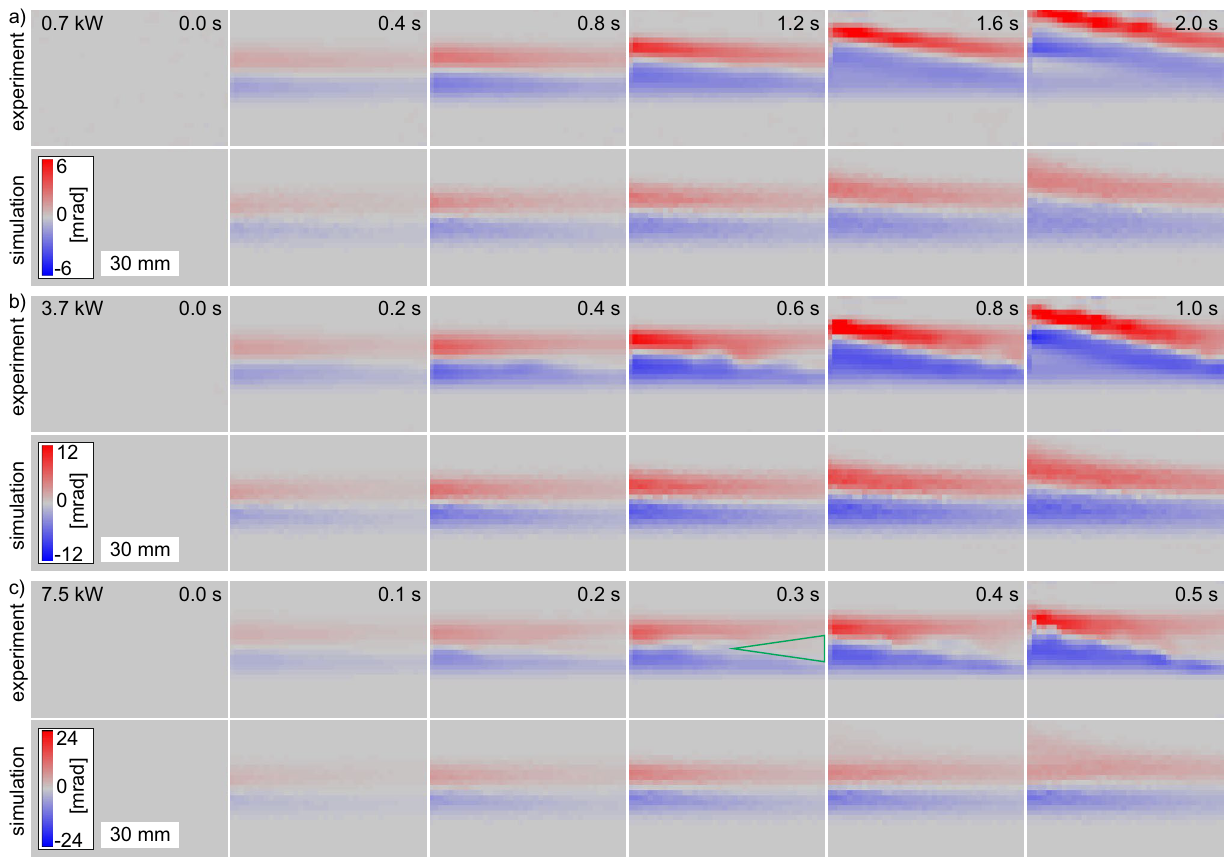
Figure 3. Differential phase, hence beamlet deflection (positive values represent deflection upwards and vice versa) of horizontal probe beam perpendicular to the high-power laser. Deflection arises due to refractive index changes because of a temperature increase during laser propagation through water. The laser (0.7, 3.7 and 7.5 kW, D 4 σ = 17.8 mm , continuous wave) is coming from the left. For all input powers an increasing beamlet shift with time and towards the entrance of the water vessel is observed. For 3.7 kW and 7.5 kW, a decreased shift is obtained in the center of the laser path in the back part of the water (green triangle as guide to the eye) due to a significantly decreased energy deposition there because of the thermally induced divergent lens. For 0.7 kW only a homogeneous spot shift increase is observed. After a certain time a convective flow sets in shown here by the upward movement of the area of spot shift. The simulations show a qualitative good agreement with the experimental